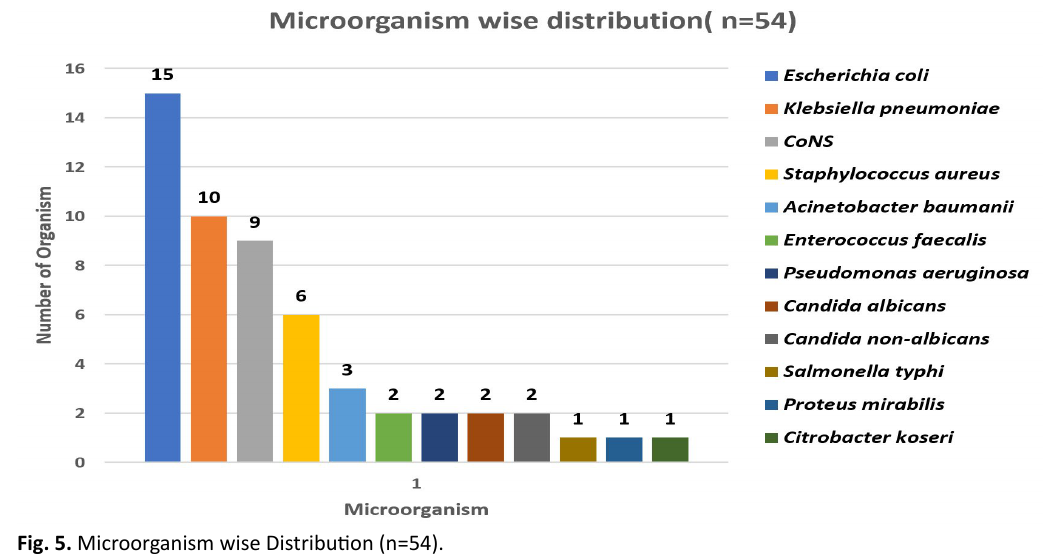
Fig. 5. Microorganism wise Distribution